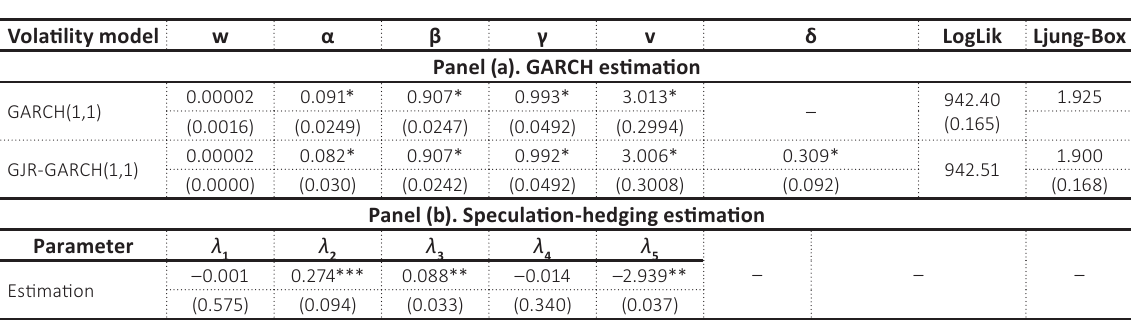
Table 2. Estimation